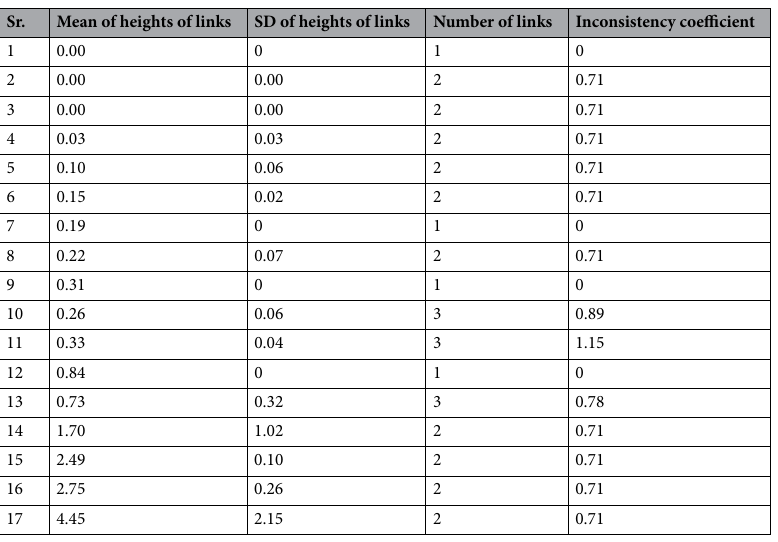
Table 9. Inconsistency measure for the links in